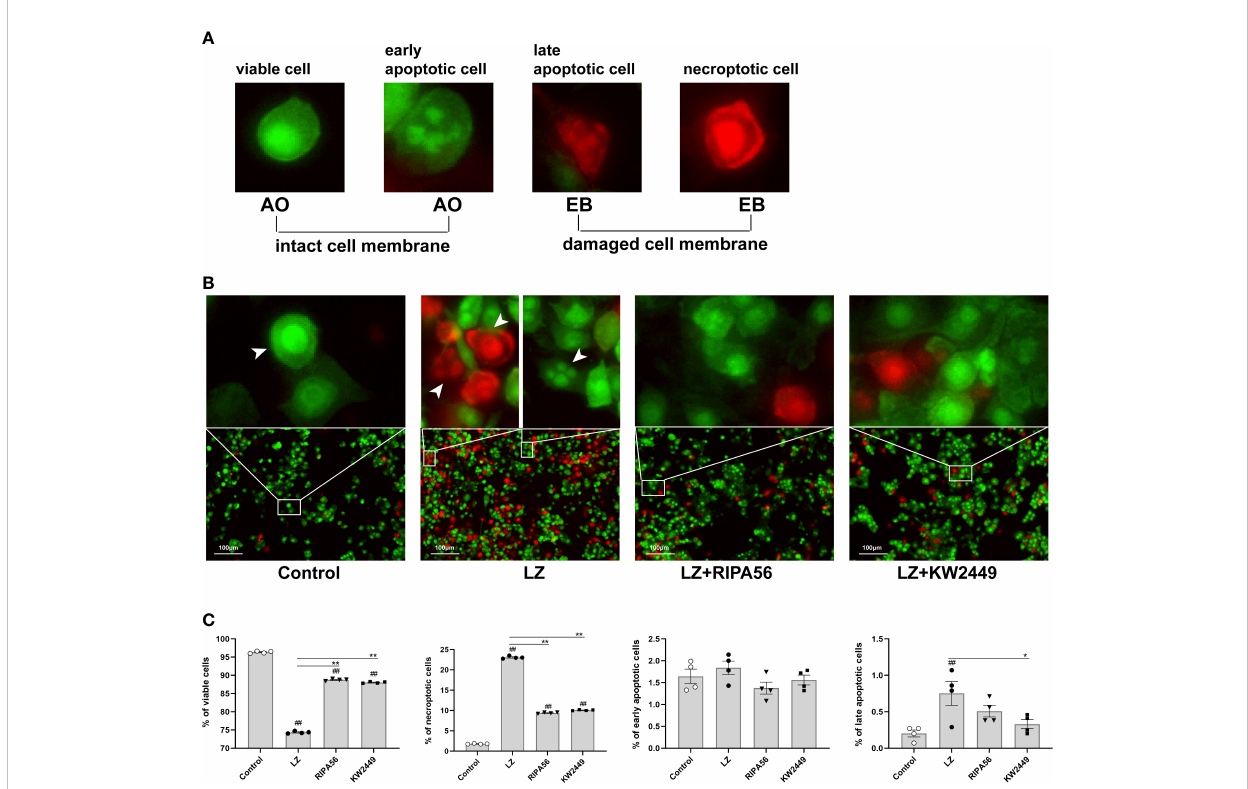
FIGURE 5 KW2449 reduced LZ-induced necroptosis in RAW 264.7 cells, as detected by AO/EB double staining. (A) Typical cell morphology in AO/EB staining. (B) Representative images of cell morphological changes in each group after AO/EB staining were observed by a high-content imaging